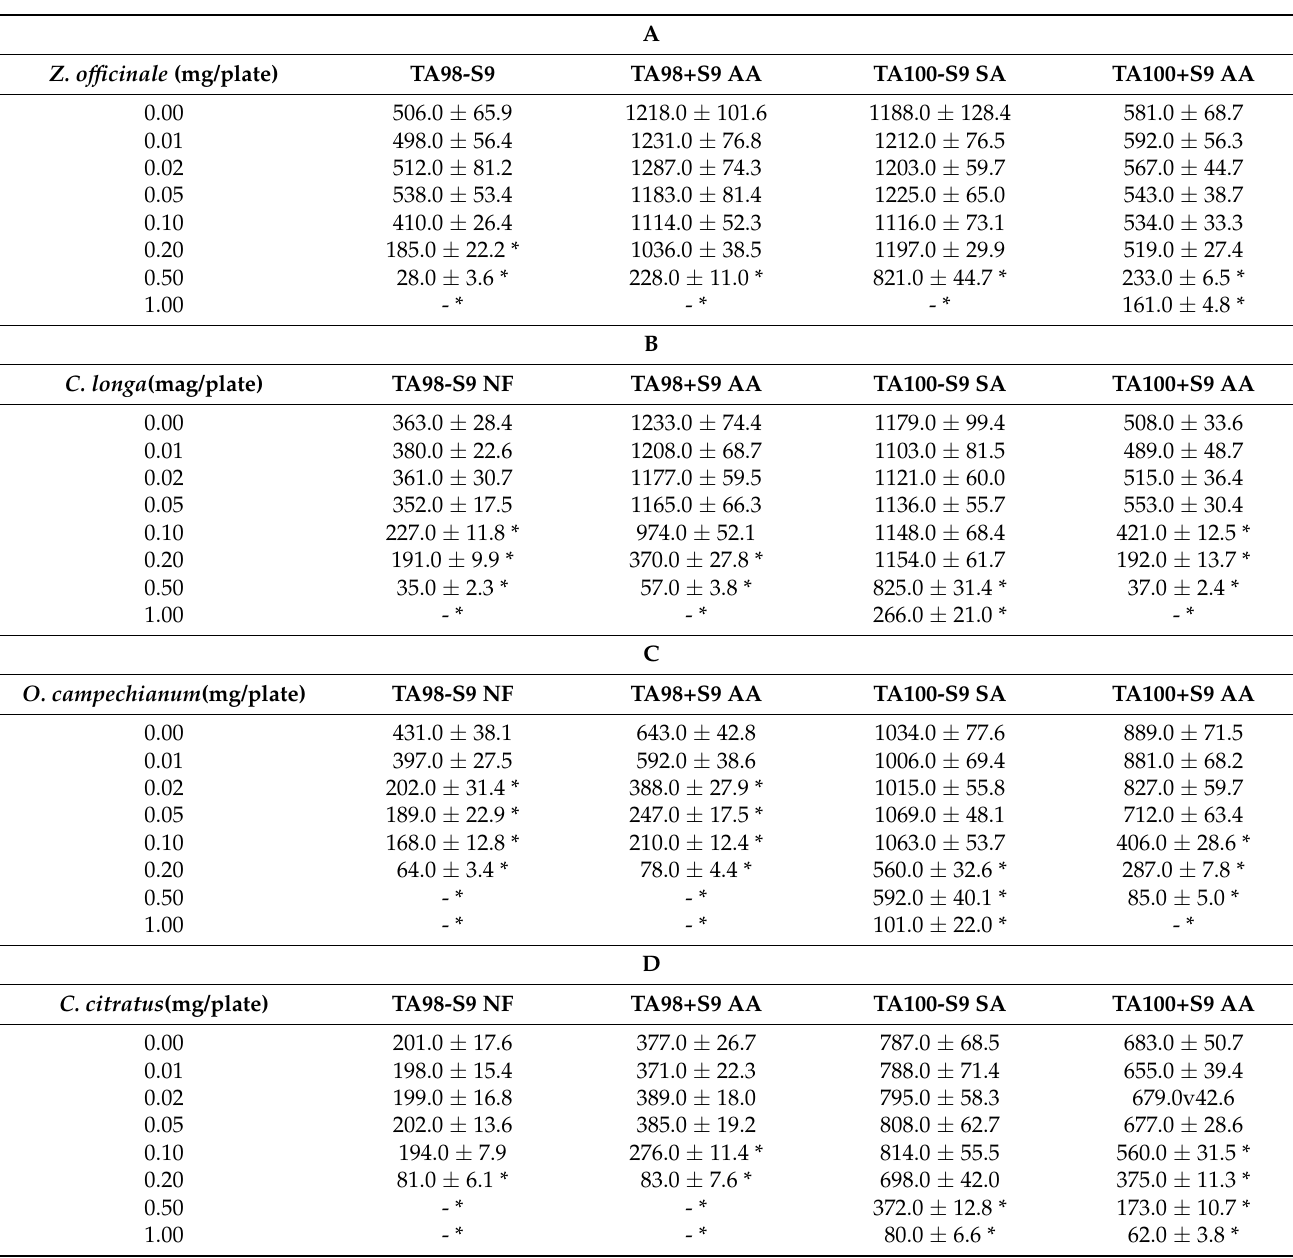
Table 7. ( A – D ). Ames test ( Salmonella typhimurium , strain TA98 and TA100) with and with- out metabolic activation (S9 mix) to assay mutagen protective activity of the four studied EOs (0.01–1.0 mg/plate concentration range) in presence of direct-acting mutagen 2-nitrofluorene (2 mg/plate; NF) and sodium azide (1 mg/plate; SA) and of the indirectly acting mutagen 2-aminoanthracene (2 mg/plate; AA). Negative controls (EOs = 0.000 mg/plate) were set up with 100 mL/plate of DMSO. The maximum concentration value (1.0 mg/plate) of the concen- tration range coincides with the maximum dose in which the EOs do not express cytotoxicity in HUD evaluation (Table 6A–D). Table 7A: Zingiber officinale EO mutagen-protective property; Table 7B: Curcuma longa mutagen-protective property; Table 7C: Ocimum campechianum mutagen- protective property; Table 7D: Cymbopogon citratus mutagen-protective property. The results are expressed both as revertants percentage (Rev.%) ± standard deviation (s.d.) and Colony Forming Units (CFU)/plate ± standard